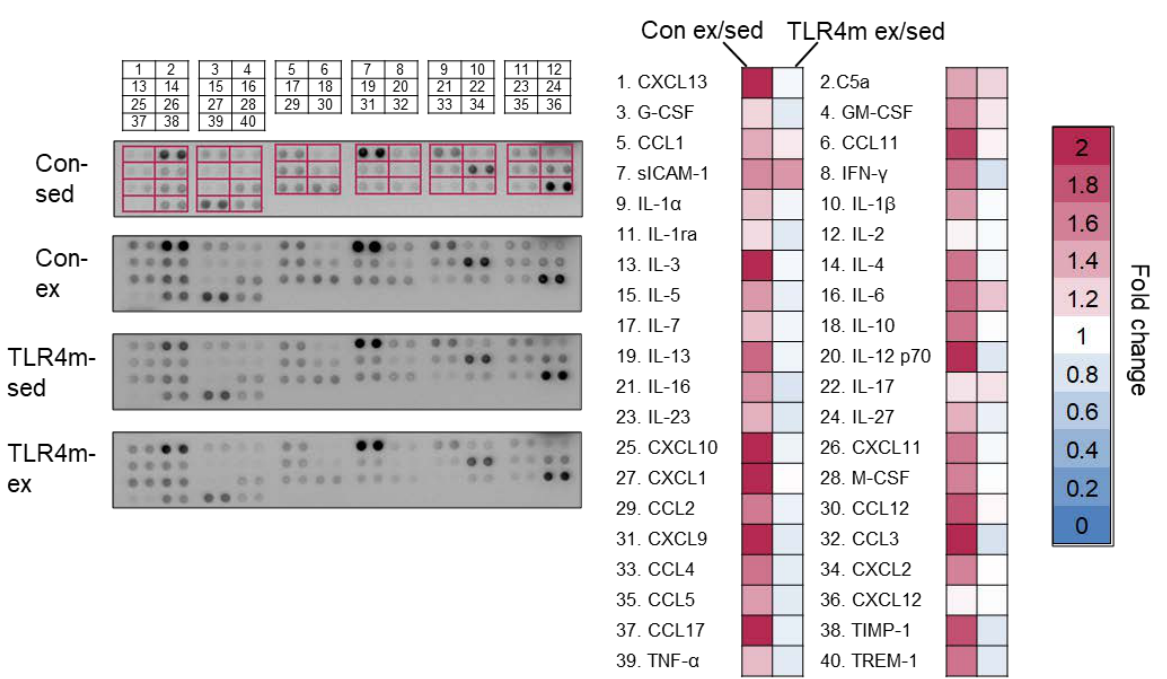
Figure 2. The relative expressions of 40 cytokines in the plantaris. Two strains of mice, TLR4 mutant (TLR4m) and controls (Con), were divided into a voluntary wheel-running group (ex) and a sedentary group (sed), respectively, and housed for six weeks. The arrangement of the 40 cytokines on the membranes is shown in the figure above. The relative values of ex to sed within each strain are represented as a heat map. n = 3 per group; Red, increased; Blue, decreased. CXCL, C-X-C motif chemokine ligand; C5a, complement component 5a; G-CSF, granulocyte colony stimulating factor GM-CSF, granulocyte macrophage colony-stimulating factor; CCL, chemokine (C-C motif) ligand; sICAM, soluble intercellular adhesion molecule; INF, interferon; IL, interleukin; M-CSF, macrophage colony stimulating factor; TIMP, tissue inhibitors of metalloproteinase; TNF, tumor necrosis factor; TREM, triggering receptor expressed on myeloid cell.